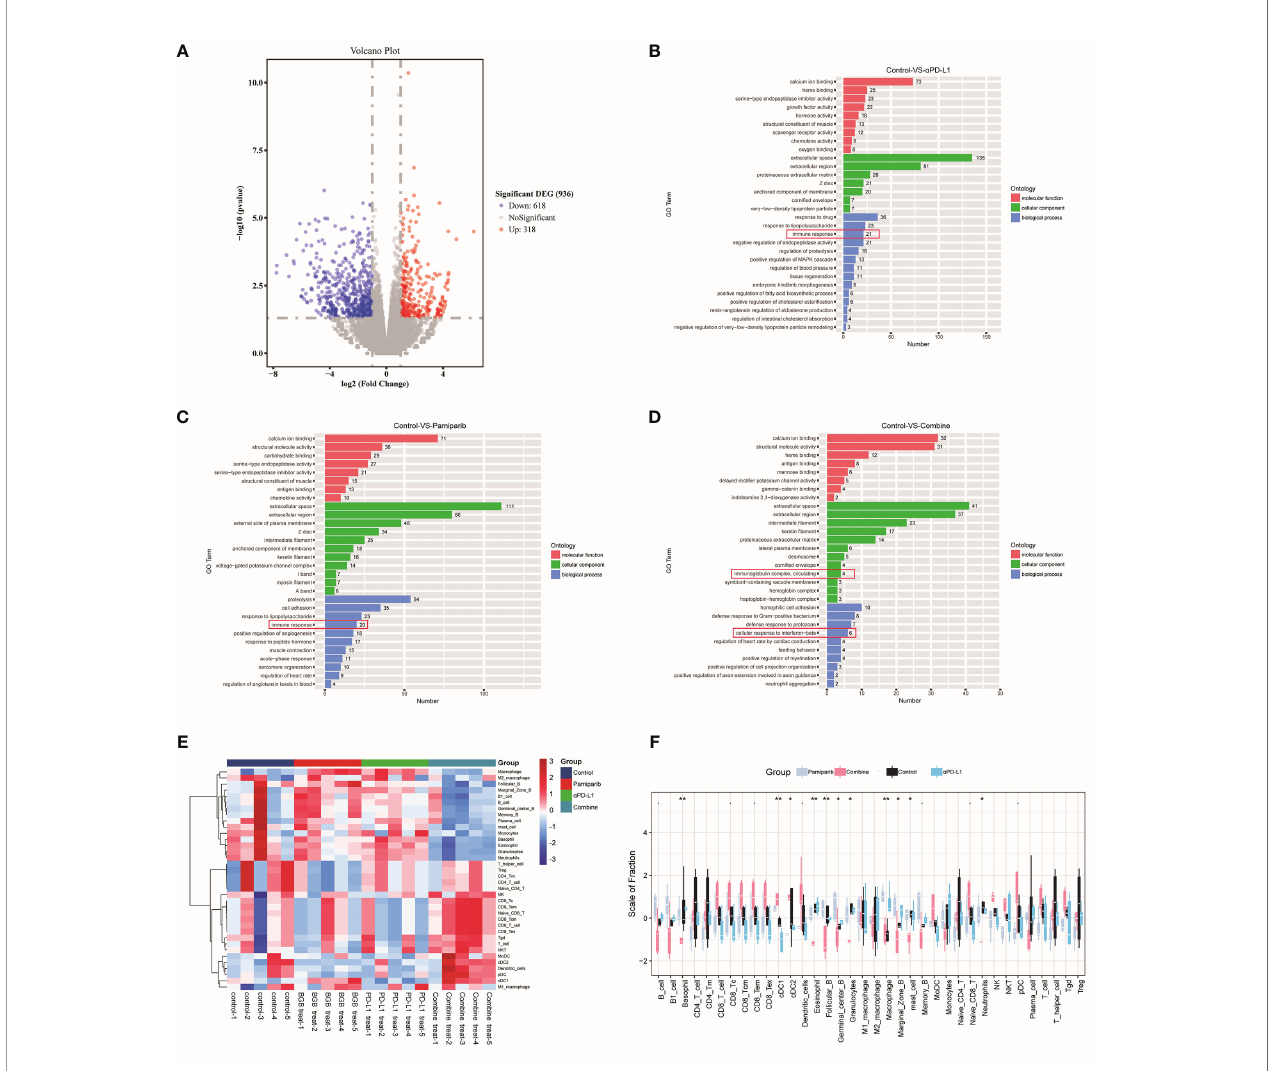
FIGURE 6 | Bioinformatic analysis suggests that combination therapy with pamiparib and PD-L1 blocker alters the immune microenvironment. (A) Volcano plot for differential genes between control and combination treatment groups. (B) Bar plot showing the top 10 enriched CC, MF and BP terms between the PD-L1 inhibitor group (PD-L1) and the control group. (C) Bar plot showing the top 10 enriched CC, MF and BP terms between pamiparib monotherapy group (BGB290) and the control group. (D) Bar plot showing the top 10 enriched CC, MF and BP terms between PD-L1 inhibitor and pamiparib combination group (Combine) and the control group. Green indicates CC term, red indicates MF term and blue indicates BP term. The numbers indicate the numbers of enriched genes in each term. (E) Heat map of 22 immune cells expression in four different groups. (F) Boxplot of 22 immune cell in fi ltrations in four different groups. Data analysis was performed by unpaired t-test. * P < 0.05, ** P <